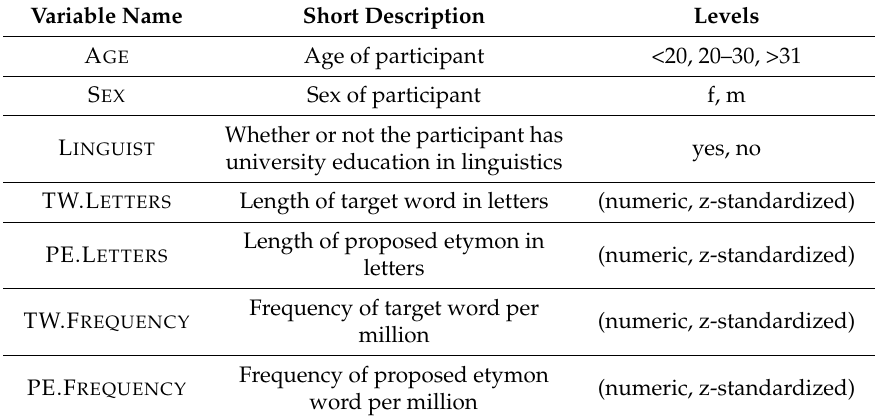
Table 1. Summary of predictor